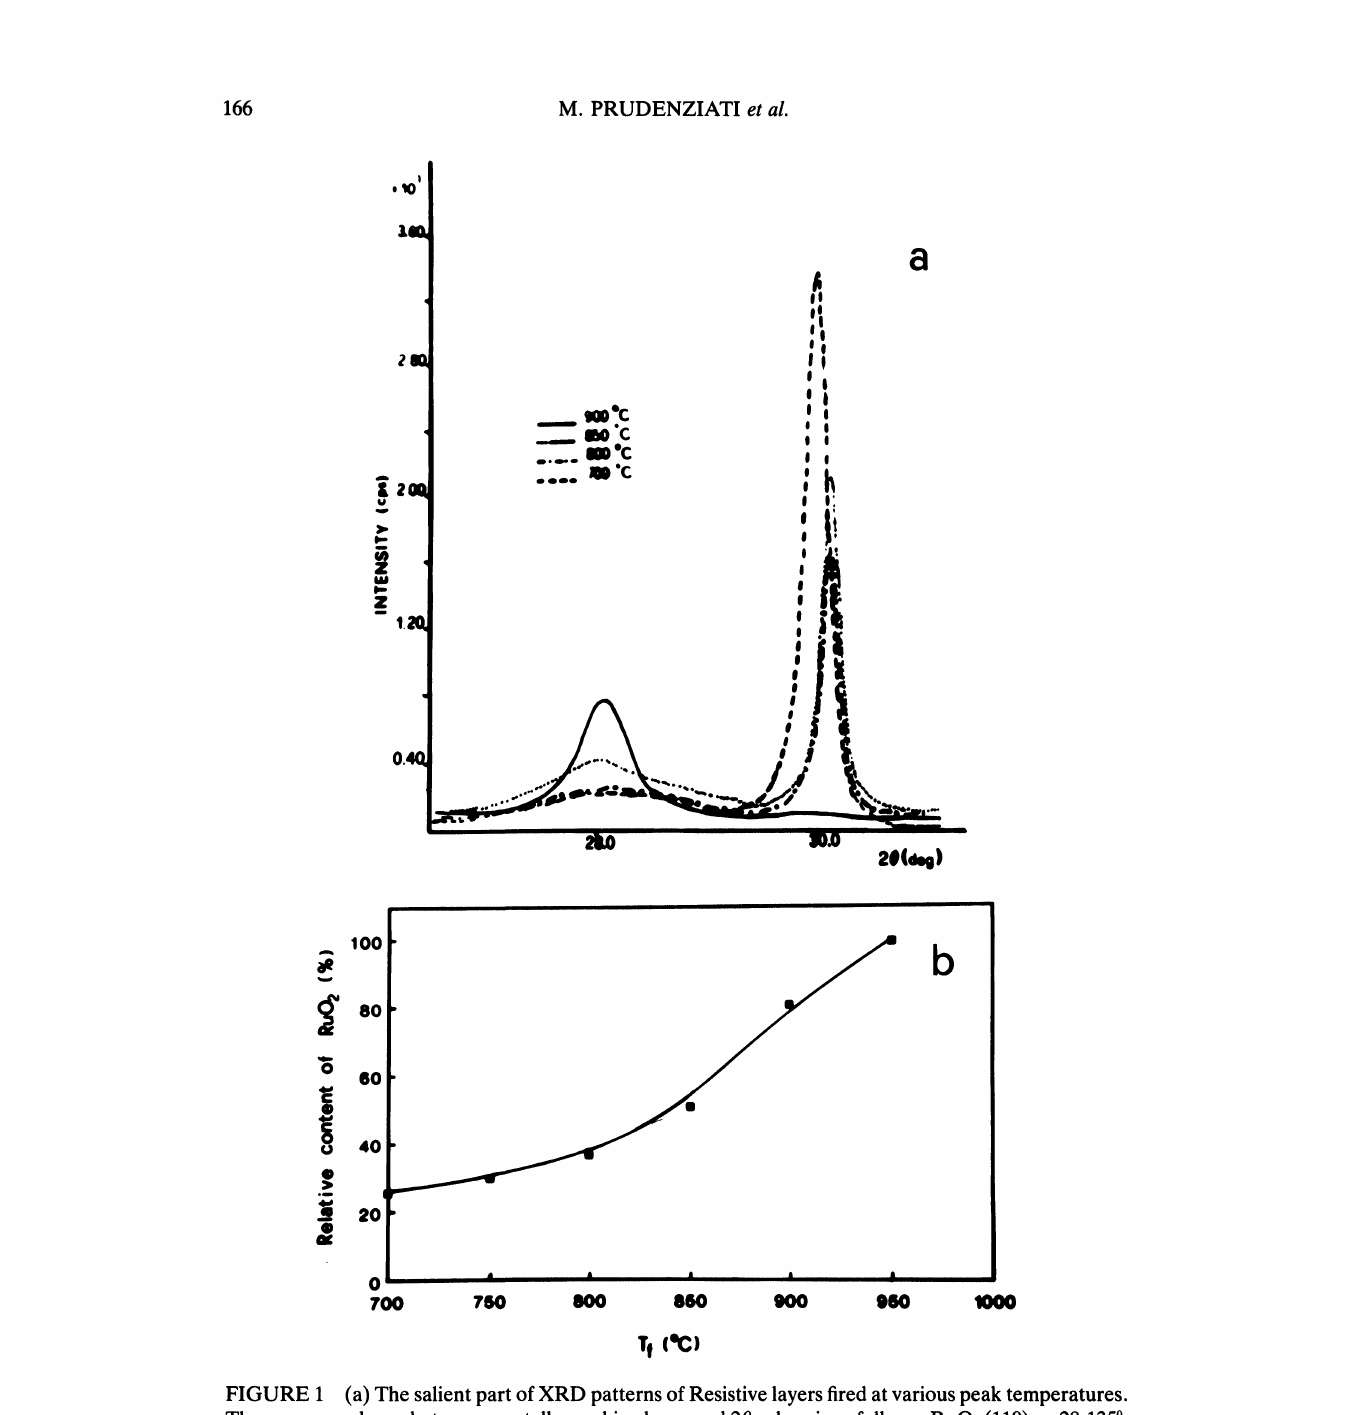
. FIGURE (a) The salient part of XRD patterns of Resistive layers fired at various peak temperatures. The correspondence between crystallographic planes and 20 values is as follows: RuO2 (110) 28.135; (b): Approximate relative content of RuO2 evaluated from the normalized Pb2Ru206.5 (222) ---, 30.15 area of rutile/(rutile + pyrochlore) XRD